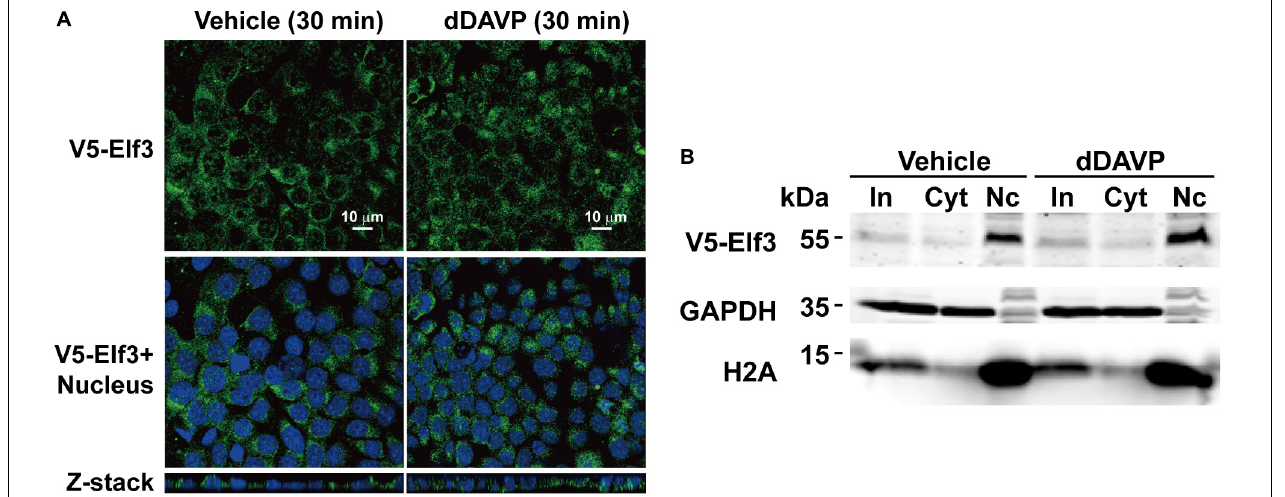
FIGURE 4 | Vasopressin did not induce Elf3 nuclear translocation in the mpkCCD cells. (A) confocal immunofluorescence micrographs of mpkCCD cells transfected with the V5-tagged Elf3 isoform 1 expression vector and stimulated with dDAVP for 30 min. (B) Nucleus (Nc) vs. cytosol (Cyt) fractionation followed by immunoblotting for V5-tagged Elf3 in the mpkCCD cells under vehicle or dDAVP-stimulated conditions. GAPDH and histone H2A were stained as a cytosol and a nucleus marker, respectively. In, input i.e., cell lysate.